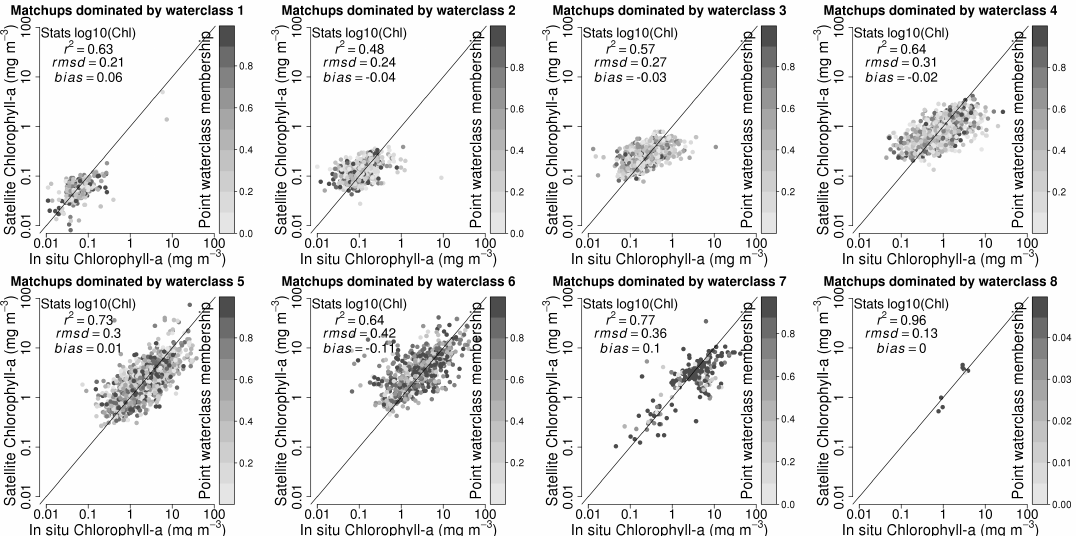
Figure 4. Comparison of in situ chlorophyll data with corresponding daily, merged satellite data for the eight water classes used in the study, for v1: The grey scale indicates the membership of water class in pixel. Note the change in grey scale for optical class 8, which has low membership values for the match-up observations. In the computation of RMSD and bias for each class, log used and the observations were weighted by the membership. The overall statistics for chlorophyll and R rs values are provided in Table 4 for all